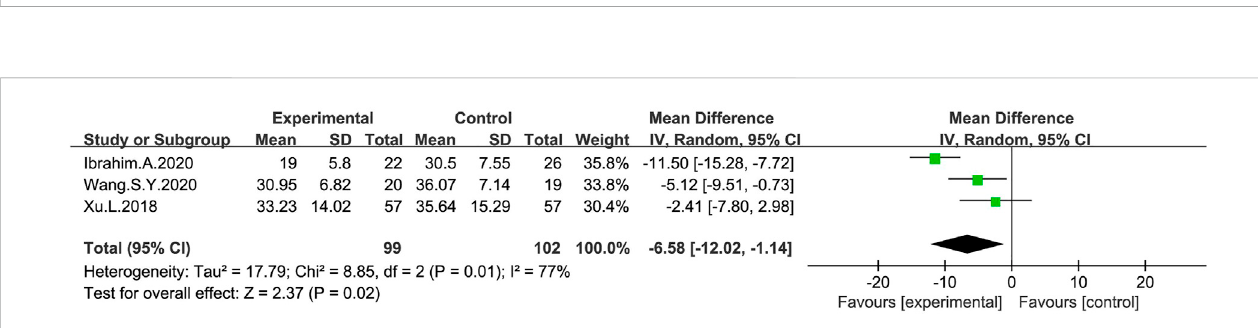
FIGURE 7 ForestplotofUPDRS-IIIscoresintheprobioticinterventiongroupversusthatofthecontrolgroup,withMDanda95%CIanalysisusingarandom-effects